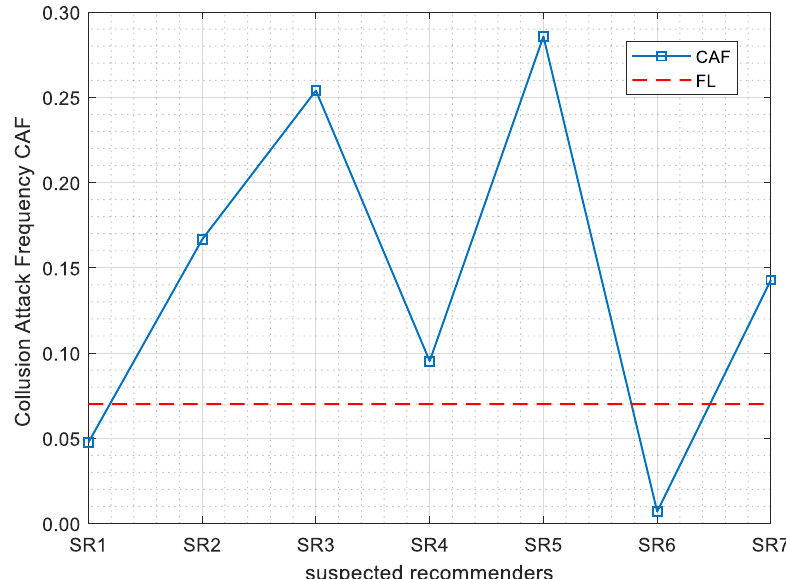
Figure 5. Collusion attack frequency.